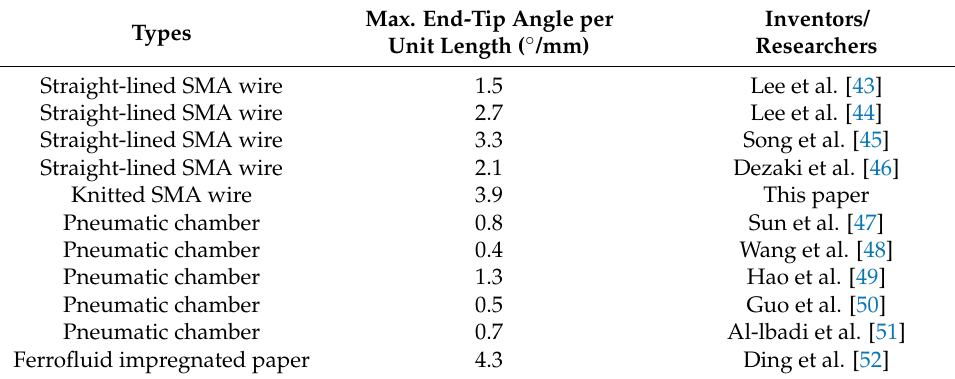
Table 2. Maximum end-tip angle per unit length comparison between previous